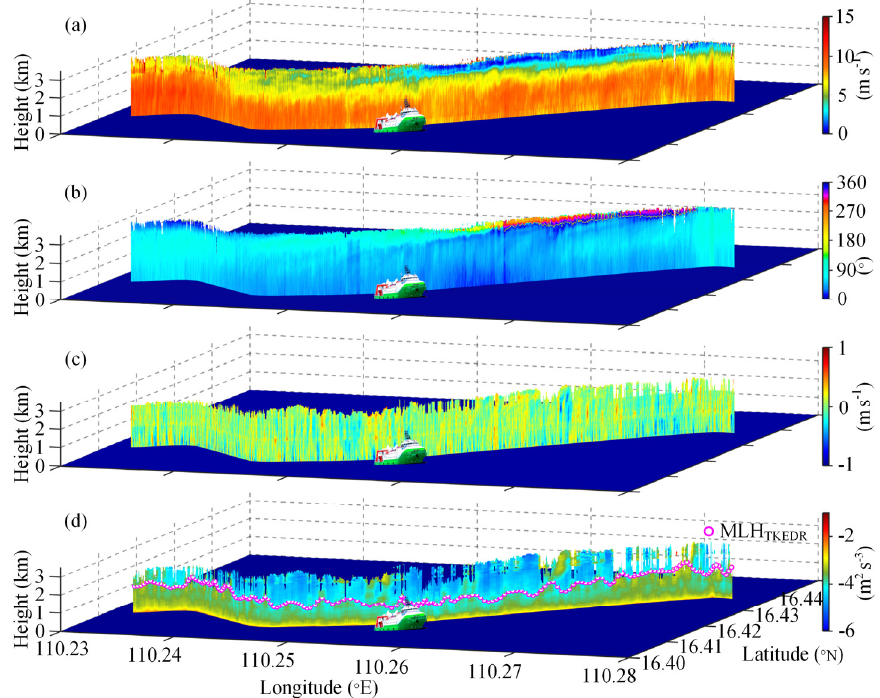
Figure 6. ( a ) Horizontal wind speed, ( b ) horizontal wind direction, ( c ) vertical wind speed, ( d ) lg(TKEDR) and its MLH retrieval result measured by ship-borne CDWL along the ship’s route in the Sea. Pink circle denotes MLH TKEDR .